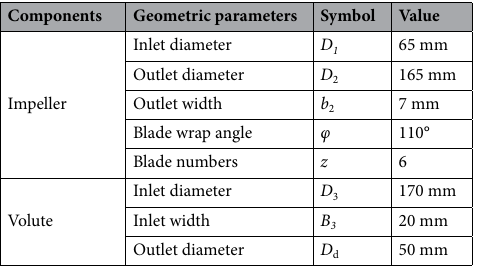
Table 1. Main geometric parameters of the marine